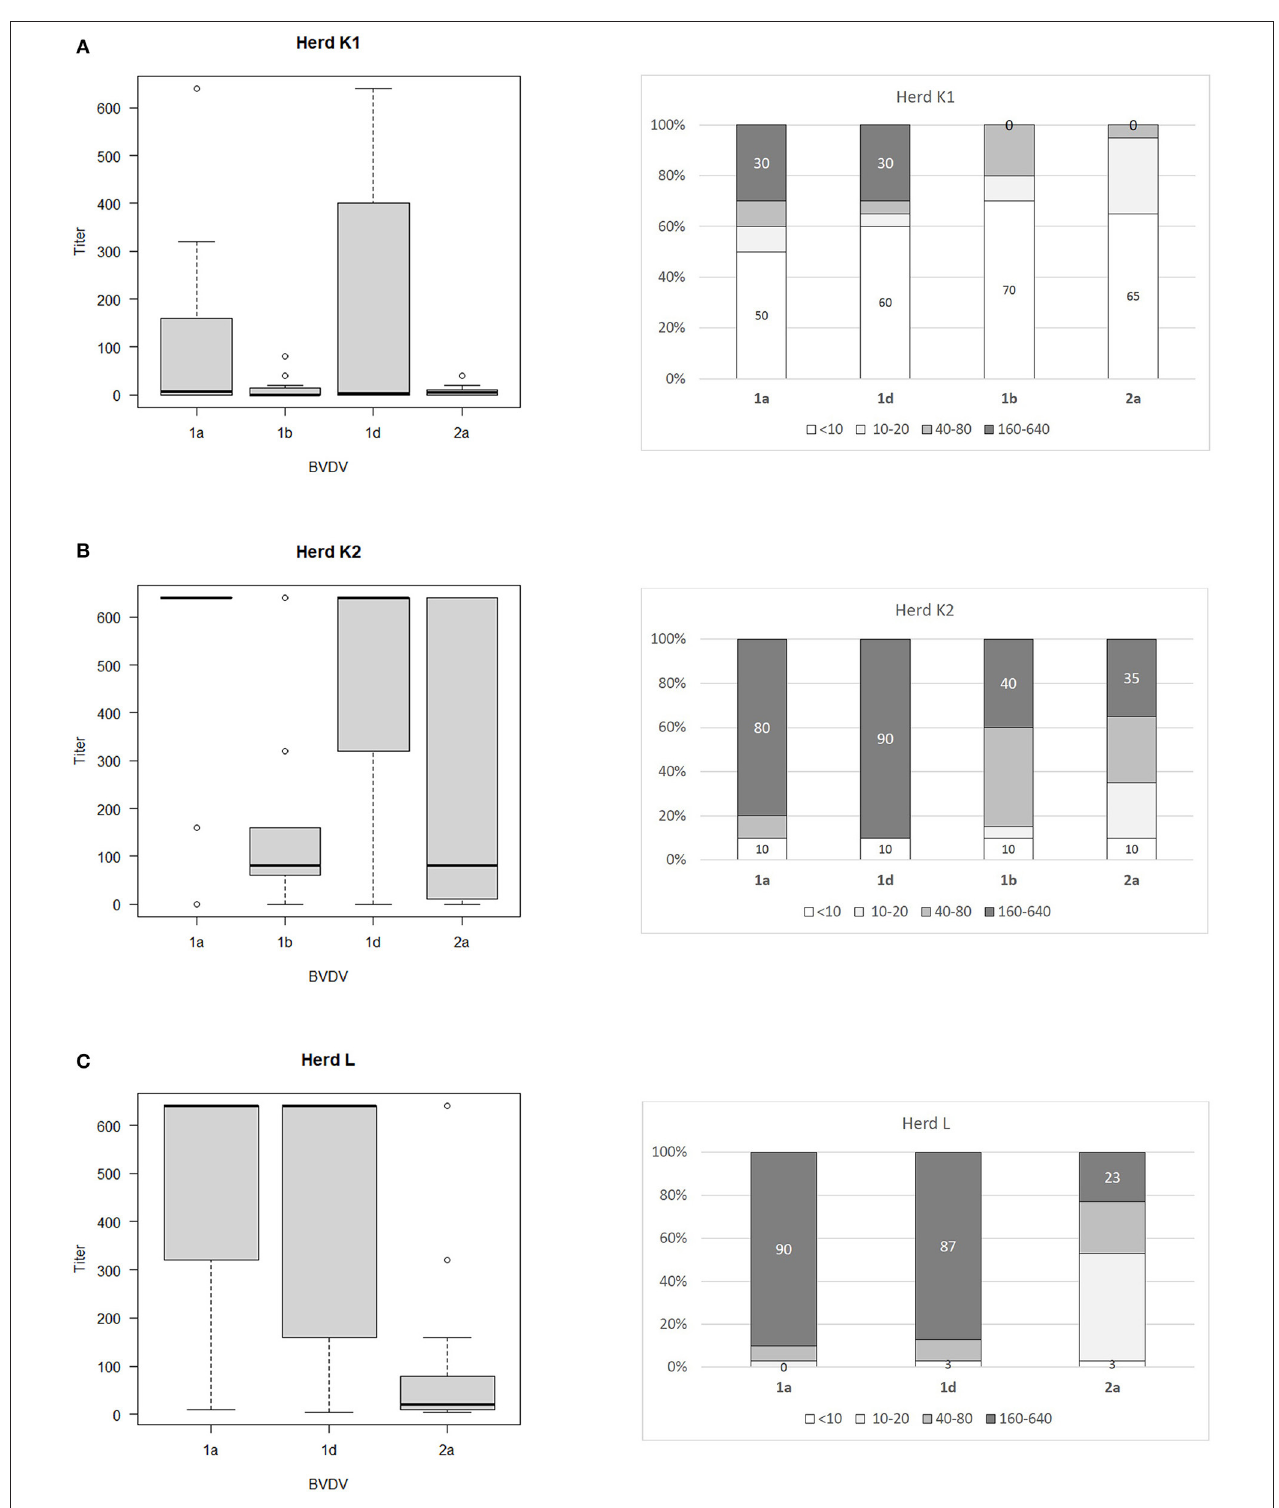
FIGURE 2 | Box and whiskers plots of antibody titers juxtaposed with percentages of antibody titers against BVDV-1a, BVDV-1b. BVDV-1d, and BVDV-2a for herds where PI animals infected with BVDV-1d were identified: (A) herd K1, (B) herd K2, (C) herd L. The top and bottom of boxes represent 25th and 75th percentiles, respectively; the middle line represents the median value, whiskers represent the highest and lowest values which are not outliers, outliers are indicated as circles. In a percentage graph, samples were classified as negative (VN titers up to 10), low (titers between 10 and 20), medium (titers between 40 and 80), and high (titers between 160 and 640) titer samples. Numbers refer to percentages of negative and high titer